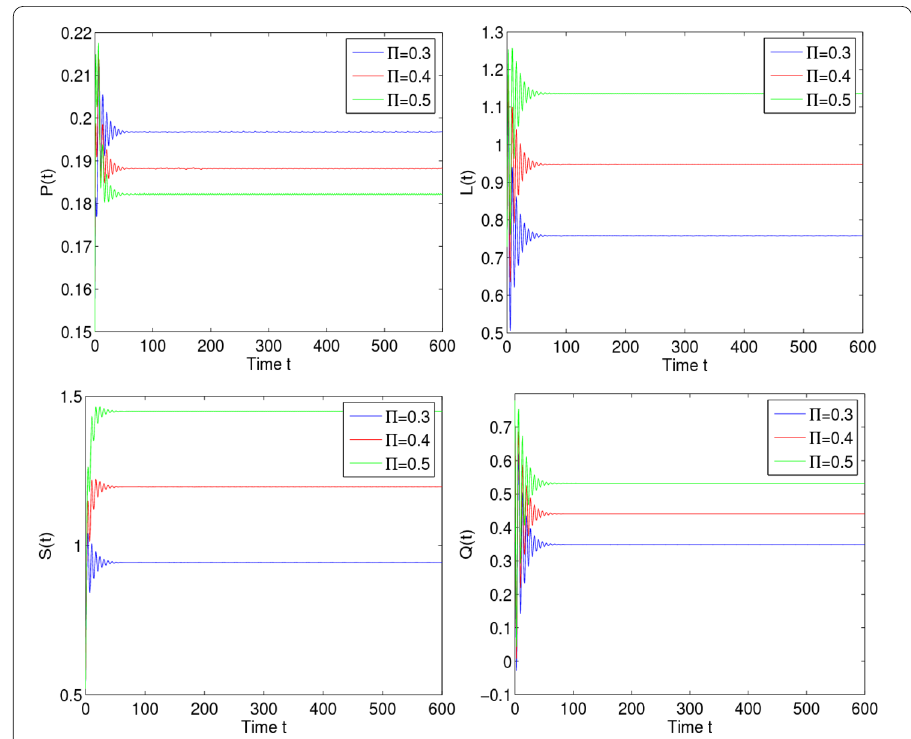
Figure 3 Time plots of P , L , S and Q for different (cid:3) at τ = 2.0505. The rest of the parameters are taken as given in the